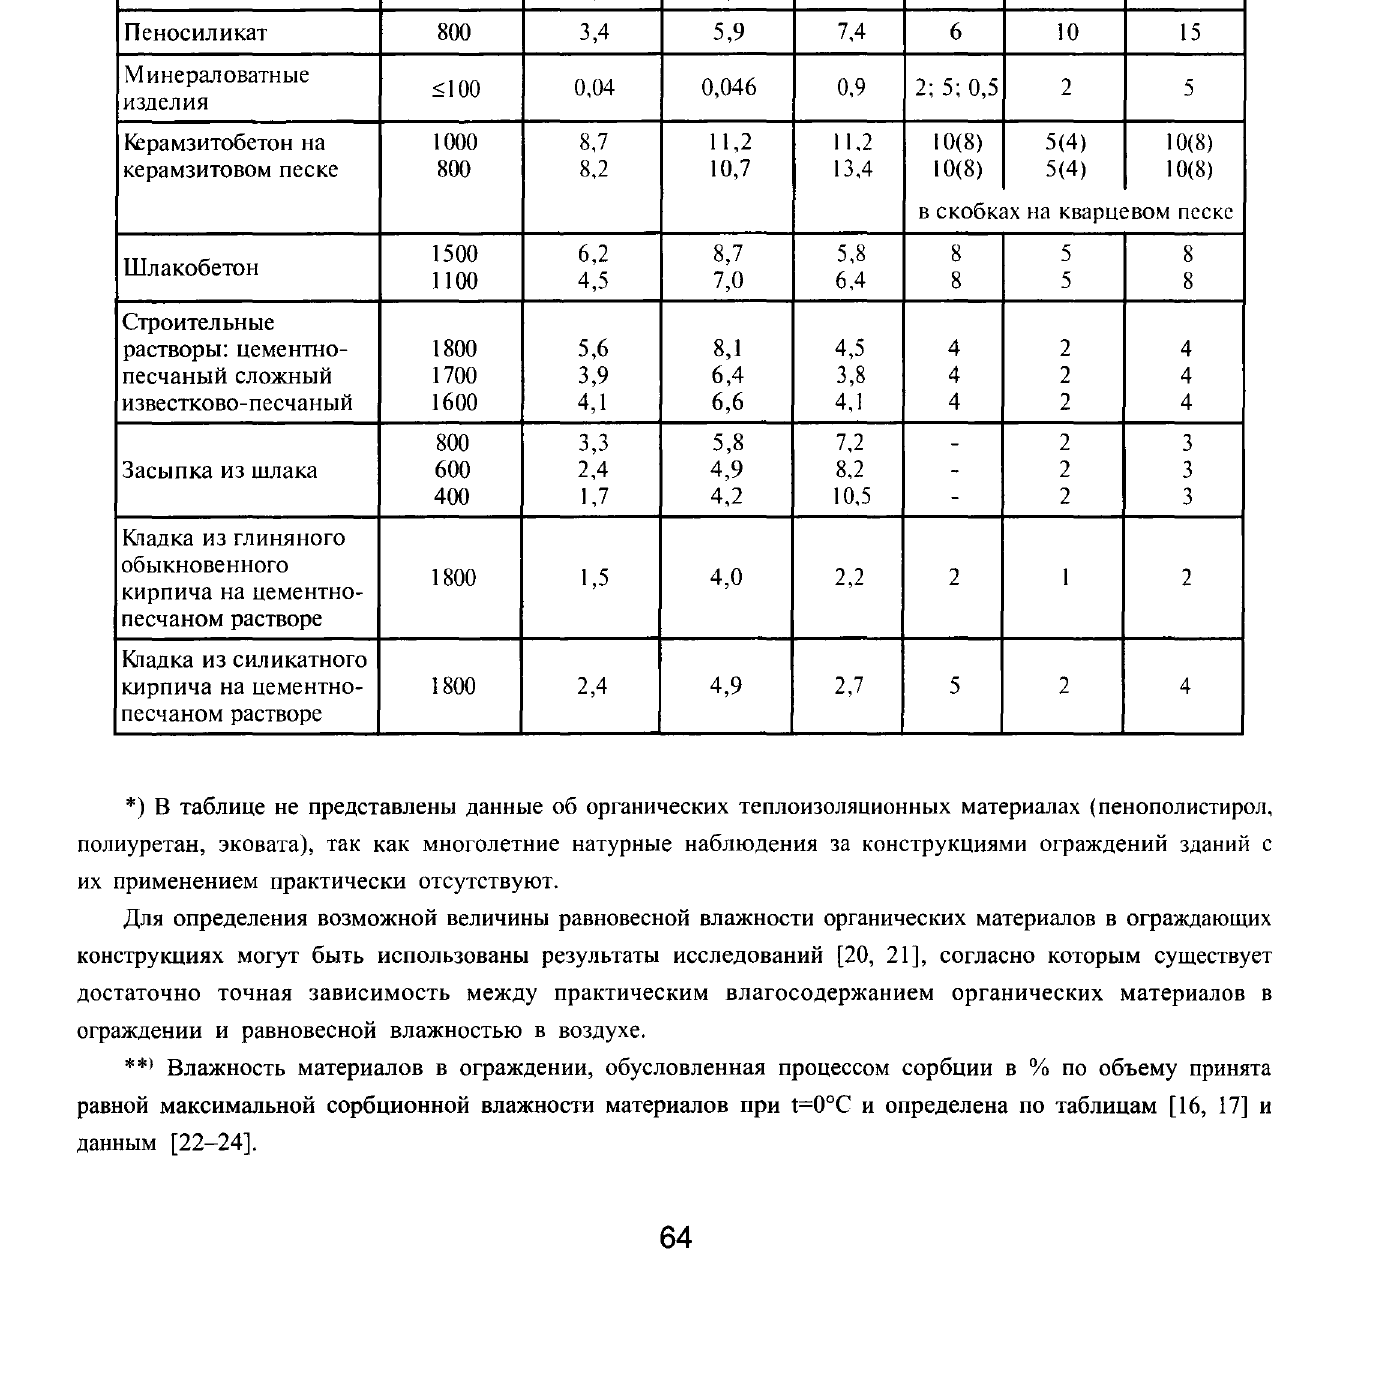
Table 2. The possible equilibrium moisture of inorganic materials in building